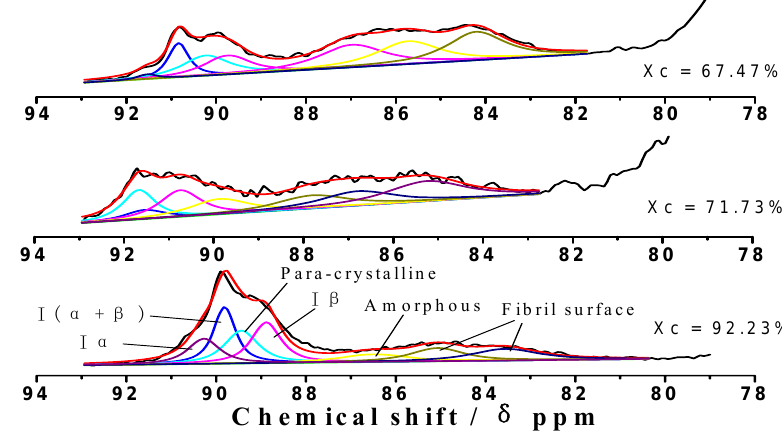
Figure 4. Results of fitting the C region of CP/MAS 13 C-NMR spectra from MCC with 4 different degrees of crystalline structure: The proportions of cellulose Ia, I(a + β ), para- crystalline, and I β are identified in the first peaks; the proportions of amorphous cellulose and fibril surfaces are identified in the second